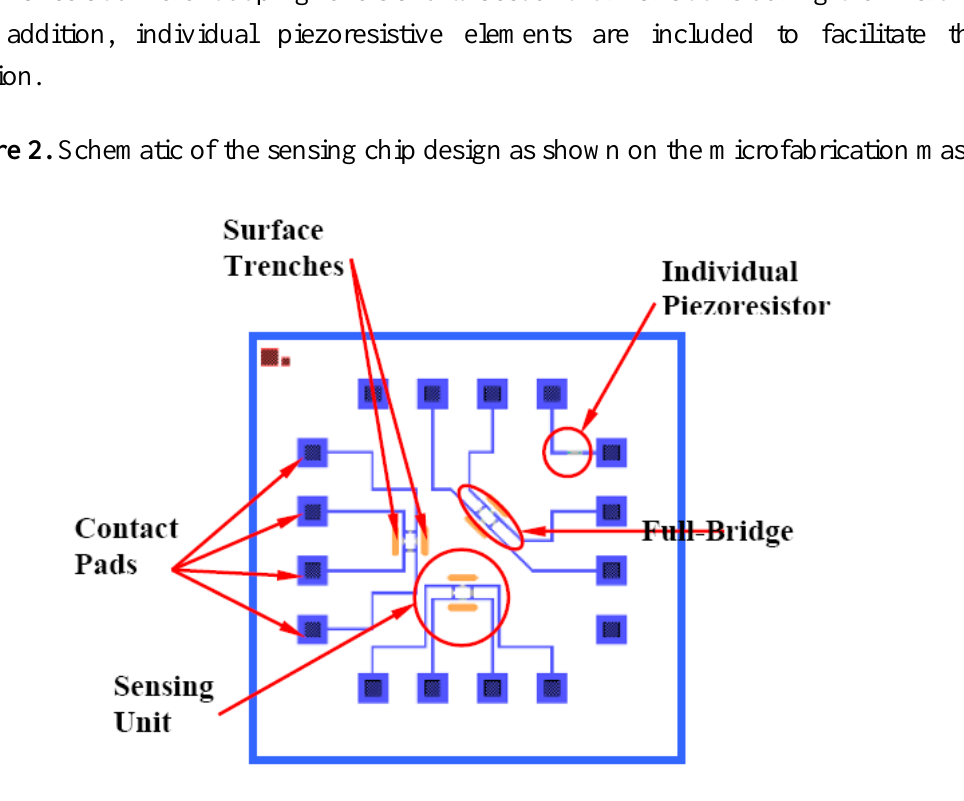
Figure 3. Dimensions of the sensing unit, sensing micro-bridge, and sensing